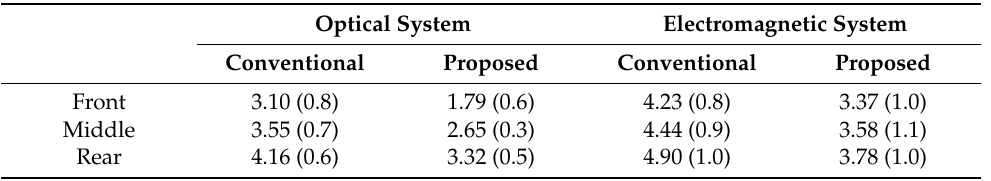
Table 1. Comparison of TRE between the conventional and proposed registration strategies and between target locations in the optical and electromagnetic